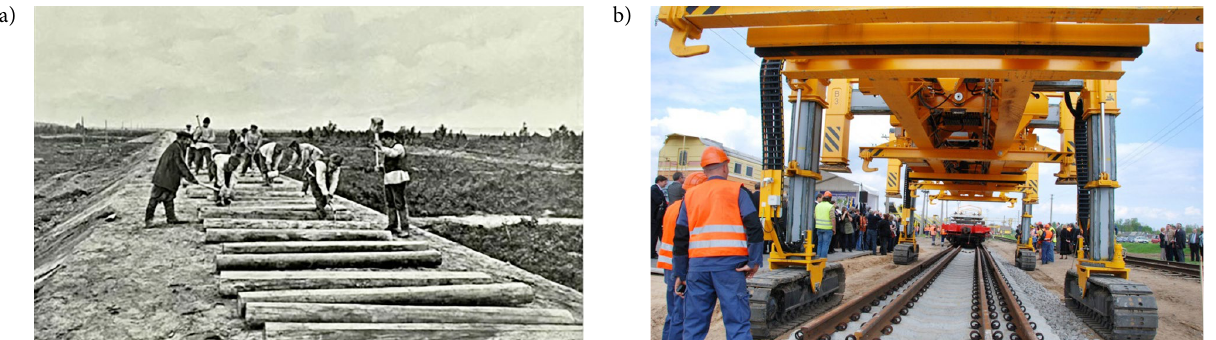
Figure 2. Railway construction: a – construction of the first railways (Husainov 2021); b – Rail Baltica construction works (LR